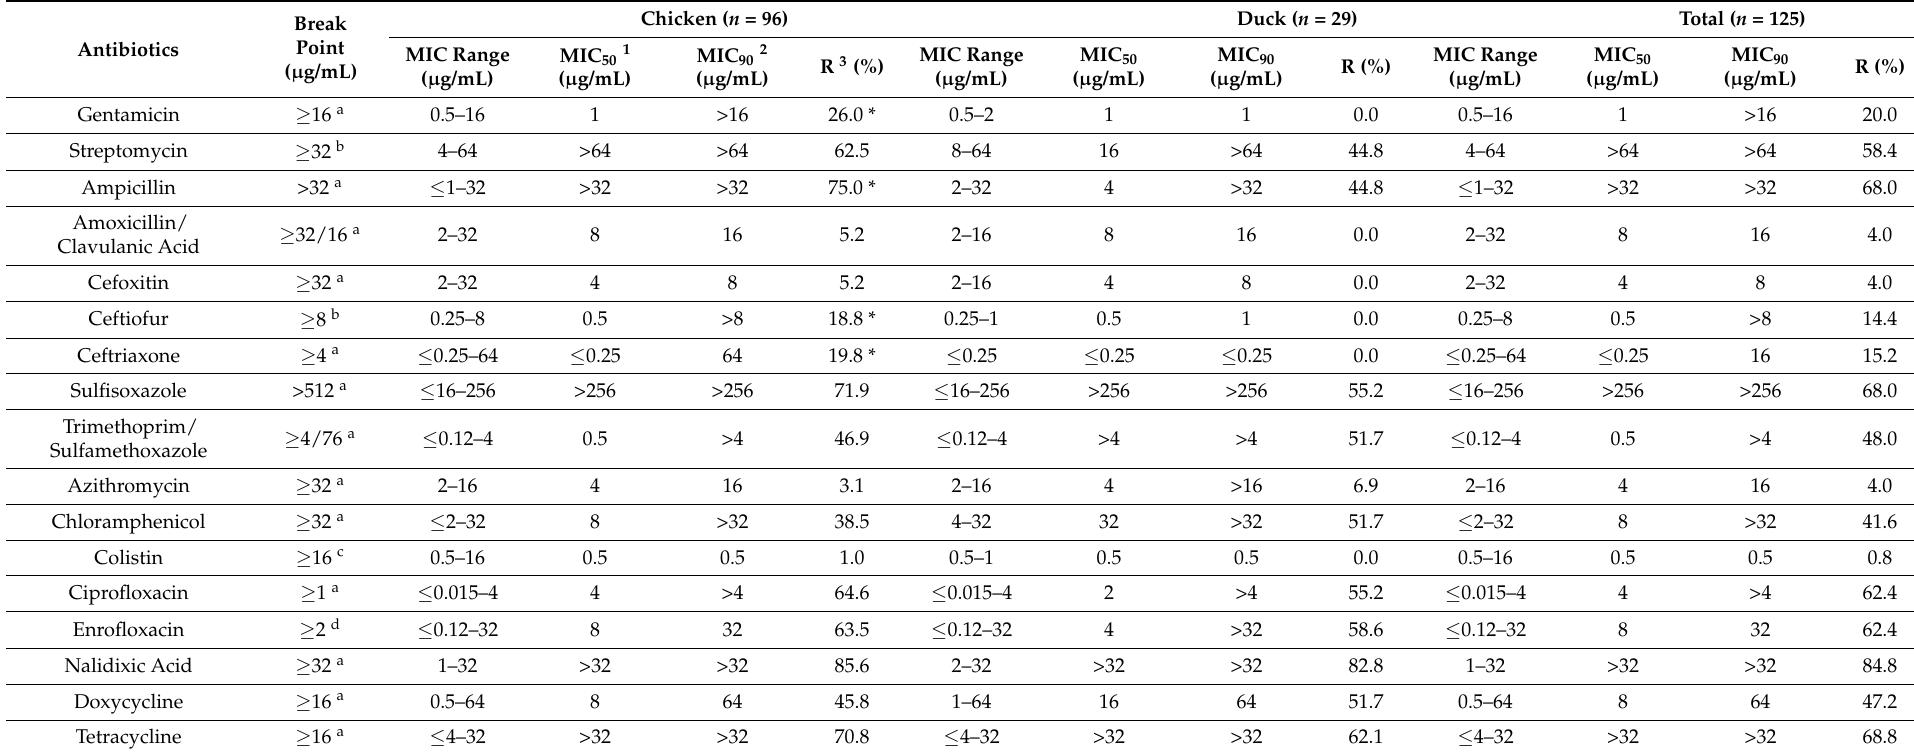
Table 4. Antimicrobial susceptibility of APEC isolates from chickens and